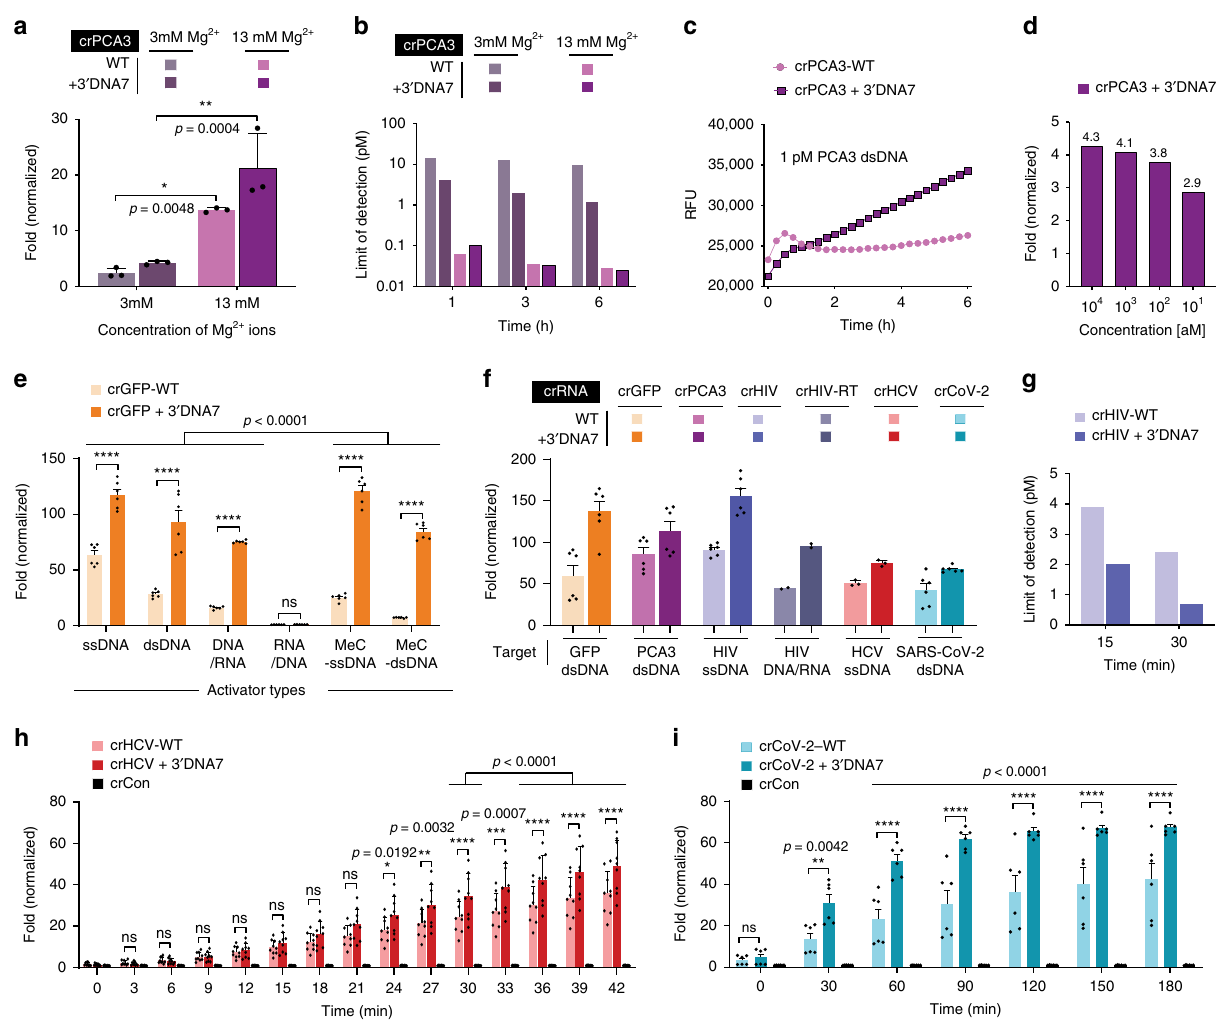
Fig. 5 Improved detection of various targets using the ENHANCE system. a Effect of Magnesium ion on the trans-cleavage activity. Error bars represent mean ± SD, where n = 3 technical replicates. Statistical analysis was performed using two-way ANOVA test with Sidak ’ s multiple comparison test, where ns = not signi fi cant, and the asterisk (*) denotes p values. b Limit of detection in femtomolar targeting PCA3 in simulated human urine at optimized Mg2 + concentration. c Raw fl uorescence data showing detectable signal difference at 1 pM of PCA3 DNA. d Fold change in fl uorescence signal of the modi fi ed crRNA + 3 ′ DNA7 targeting GFP after the recombinase polymerase ampli fi cation (RPA) step. e Effect of heteroduplex DNA-RNA and methylated activators on the trans-cleavage activity of LbCas12a. f trans-cleavage activity of different DNA targets. GFP, PCA3, COVID-19, and HCV are dsDNA activators, and their fl uorescence shown were taken after 3 h. The HIV target is ssDNA or cDNA/RNA heteroduplex, and its fl uorescence signal shown was taken after 1 h. g Limit of detection targeting HIV cDNA fragment after 15 and 30 min. Results in b and g are based on the limit of detection calculations. h Fold change in trans-cleavage activity with LbCas12a in presence of 100 pM (10 fmols) of target HCV ssDNA. Using modi fi ed crRNA, the limit of detection of HCV target ssDNA was found to be 290 fM (29 amoles) at 30 min, without target ampli fi cation. i Fold change in trans-cleavage activity with LbCas12a in presence of 100 pM (10 fmols) of target SARS-CoV-2 cDNA (dsDNA). For h , error bars represent mean ± SEM, where n = 9 replicates (three technical replicates examined over three independent experiments). For e , f , and i , error bars represent mean ± SEM, where n = 6 replicates (three technical replicates examined over two independent experiments). For e , h , and i , statistical analysis was performed using a two-way ANOVA test with Dunnett ’ s multiple comparison test, where ns = not signi fi cant with p > 0.05, and the asterisks (*, **, ***, ****) denote signi fi cant differences with p values listed above. Source data are available in the Source Data fi